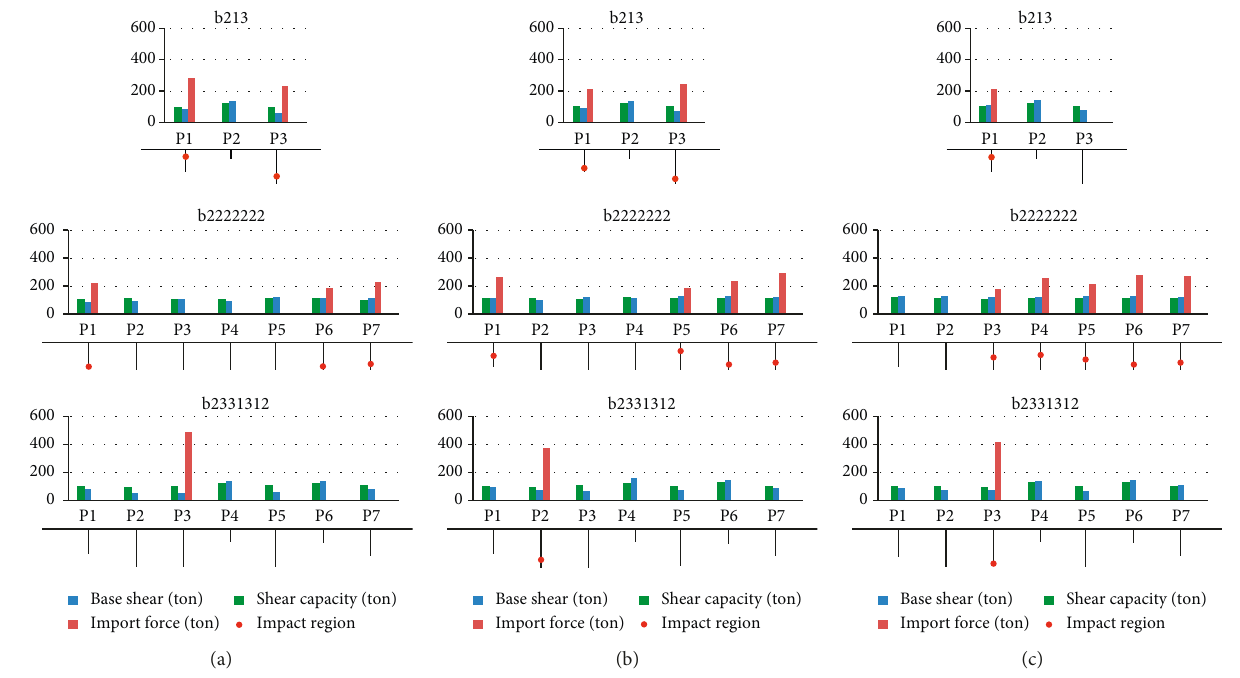
Figure 21: General information and overall view of comparing impact force with seismic base shear forces and the collision region in b213, b222222, and b2331312 bridges under (a) Chi-Chi earthquake, (b) Kobe earthquake, and (c) Northridge earthquake.